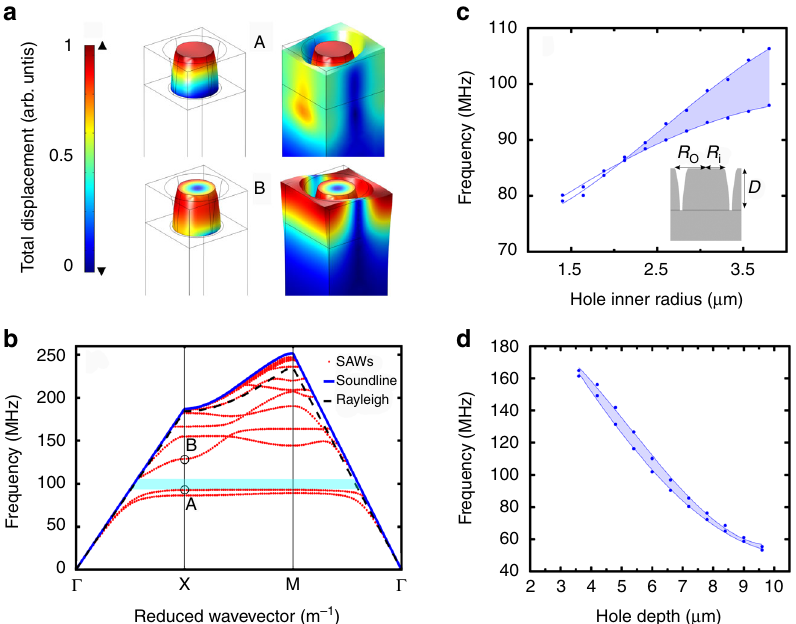
Fig. 1 Simulated PnC band diagram, displacement pro fi les and tailorability plots. a Total displacement surface plots for modes A and B for the entire unit cell and for only the locally resonant structure. b SAW band diagram generated through fi nite element method simulation of annular hole unit cell with pitch 10.9 µ m, inner radius 3.1 µ m, outer radius 5.1 µ m and hole depth 6.4 µ m. The blue line represents the soundline and the red lines represent propagating SAW bands within the 1st Brillouin zone. The teal bar represents the PnC complete bandgap. c Bandgap limits of annular hole PnC against inner radius of the holes with cross section schematic of unit cell, with R o , R i and D being the outer radius, inner radius and depth of the annular hole respectively. The data points represent upper and lower frequency limits of the complete bandgap shaded in blue . The lines are polynomial fi ts to guide. d Bandgap limits against depth of the